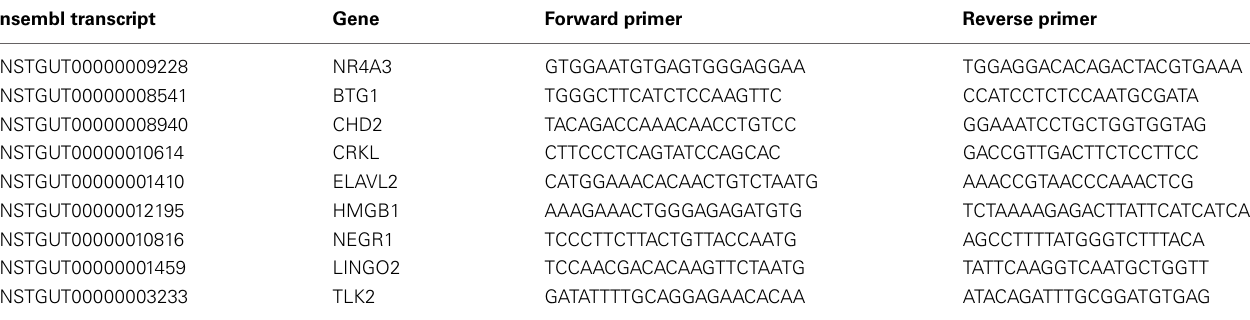
Table 1 | Primers used for qRT-PCR analysis of predicted target genes. Ensembl transcript